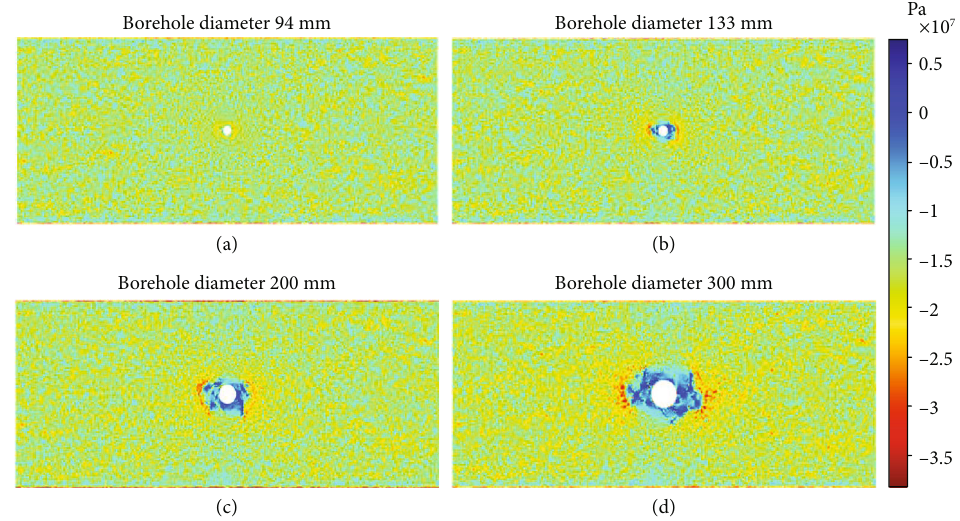
Figure 7: Distribution of maximum principal stress in soft coal seam with di ff erent borehole diameters.